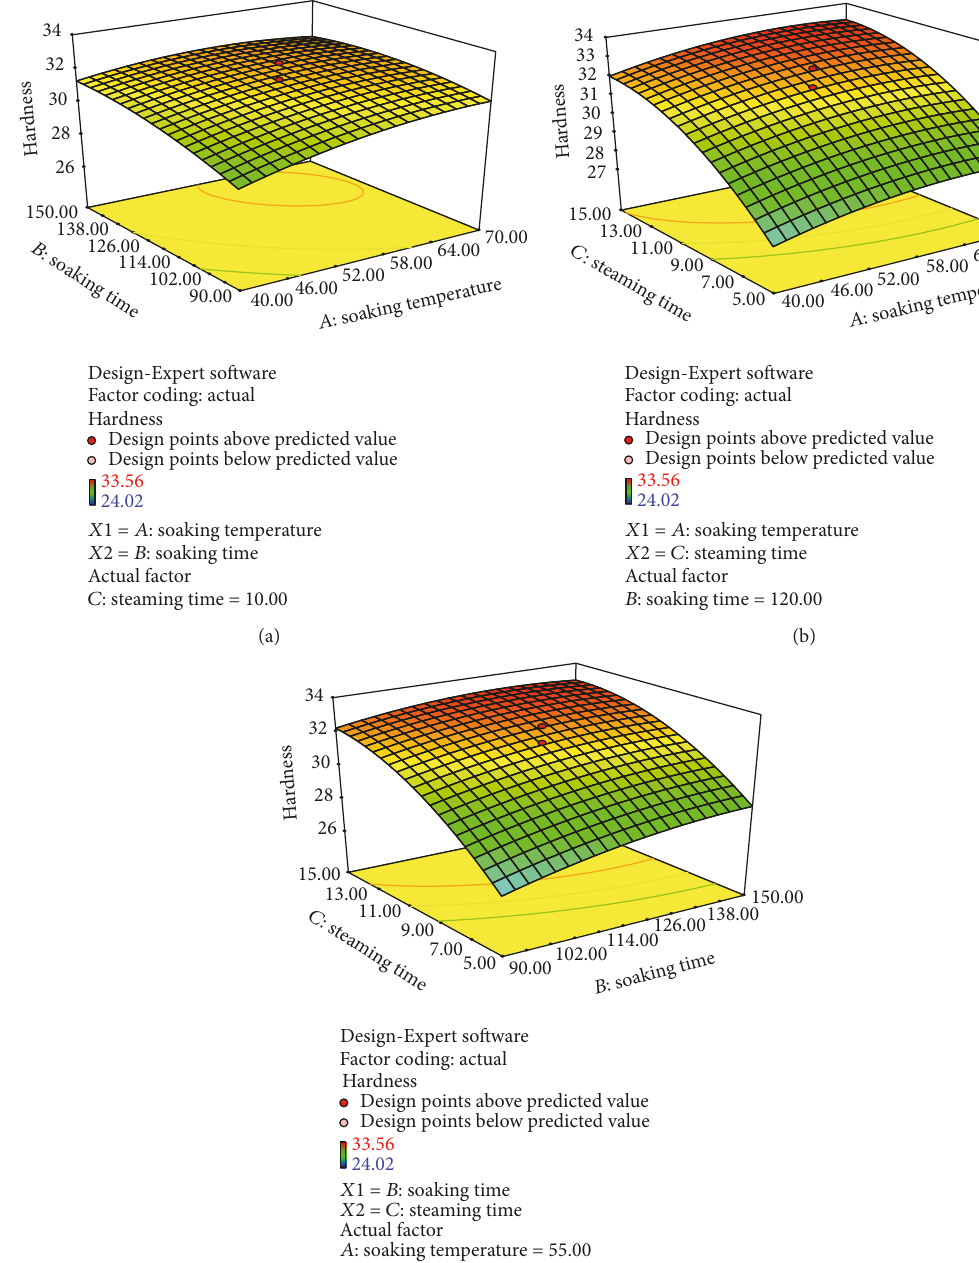
Figure 3: Interactional effect of three variables on hardness of rice